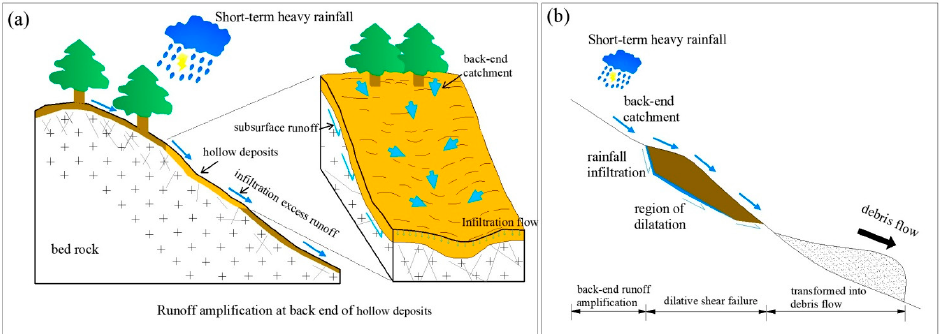
Figure 8. Schematic diagram of low-frequency debris flow triggered by the initiation of the CDH in the watershed.